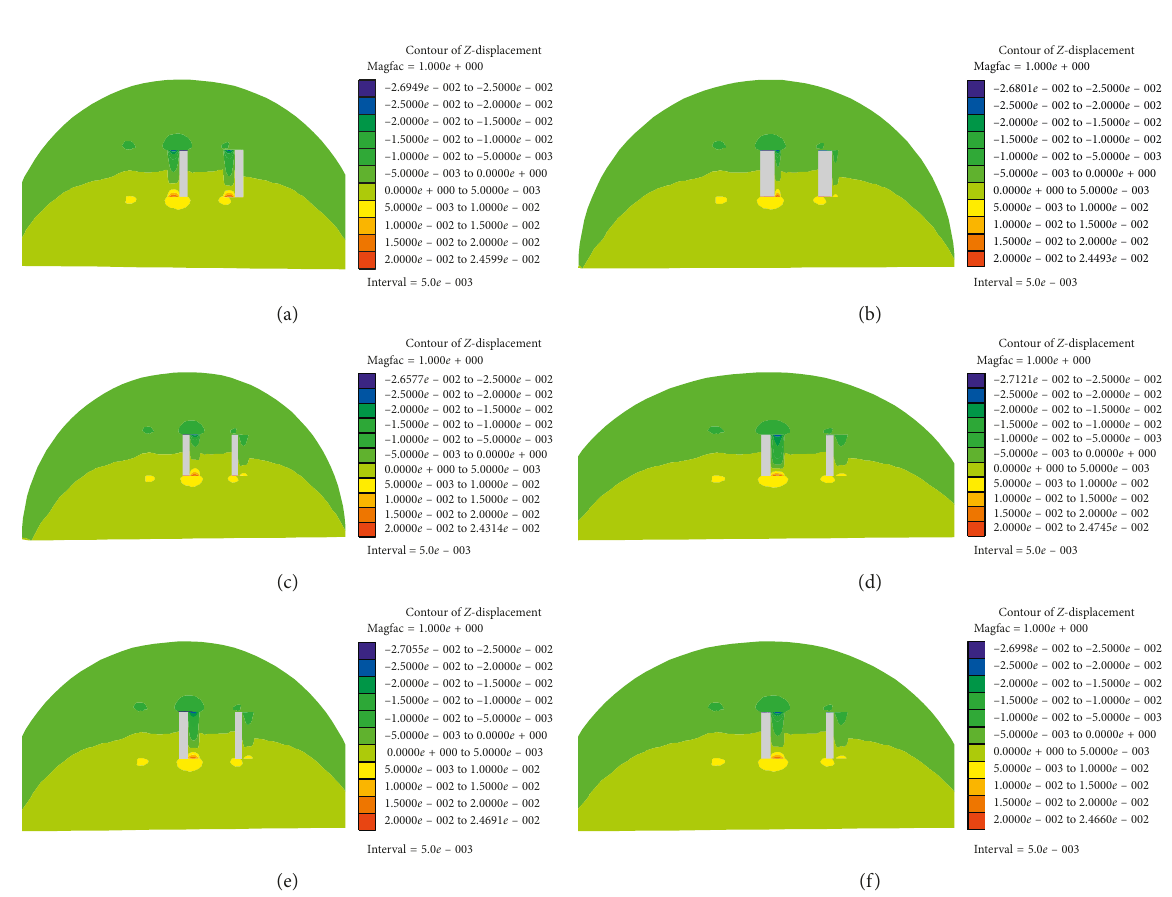
Figure 6: Vertical displacement cloud: (a) cement-sand ratio 1 :6, backfill concentration 68%; (b) cement-sand ratio 1: 6, backfill con- centration 72%; (c) cement-sand ratio 1 :6, backfill concentration 78%; (d) cement-sand ratio 1: 8, backfill concentration 68%; (e) cement- sand ratio 1: 8, backfill concentration 72%; (f) cement-sand ratio 1 :8, backfill concentration